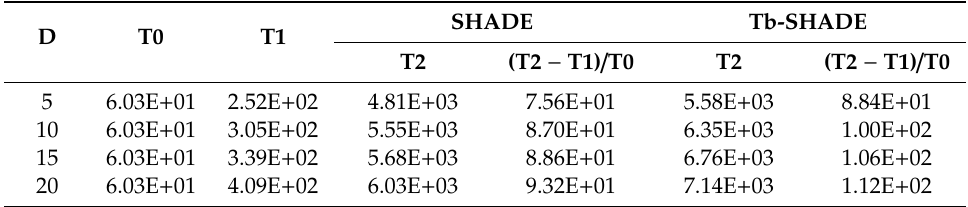
Table 1. Time complexity specified by CEC2020 technical document-SHADE vs. Tb-SHADE.